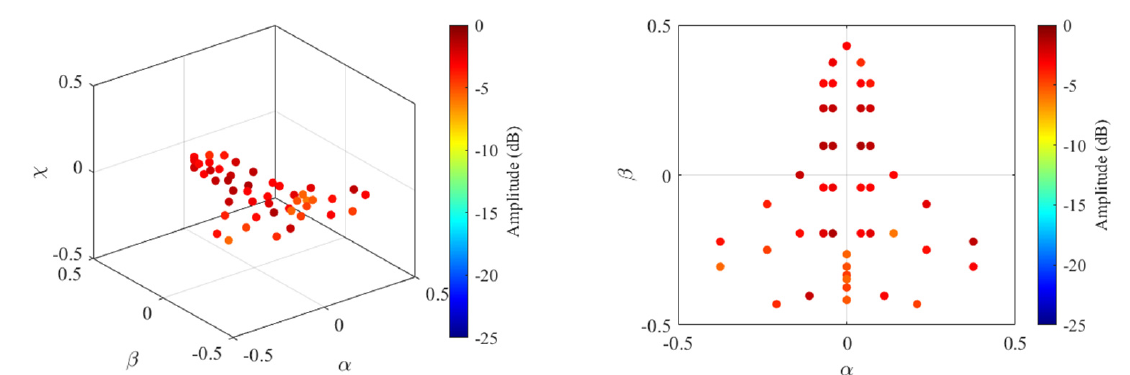
Figure 18. Target imaging result obtained by TSL0 with random sparse-sampled signal cube.